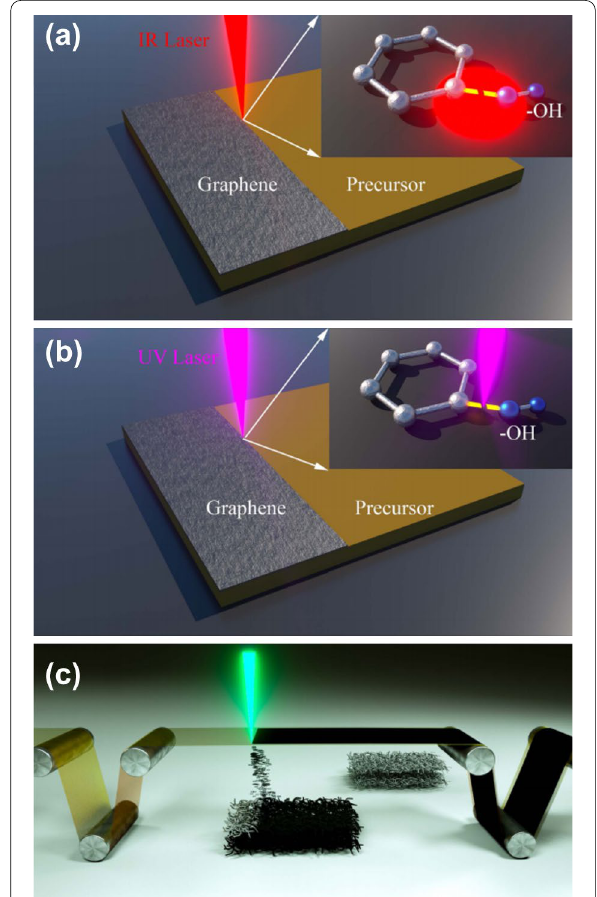
Fig. 2 Schematic illustration of a the photothermal process within the laser writing of graphene electrode; the inset image demonstrates the thermal breaking between C and O–H bonds. b The photochemical process within the laser writing of graphene electrode; the inset image demonstrates the photon induced disassociation of band between C and O–H. c The laser induced forward transfer of graphene based on the roll‑to‑roll production with a polyimide film